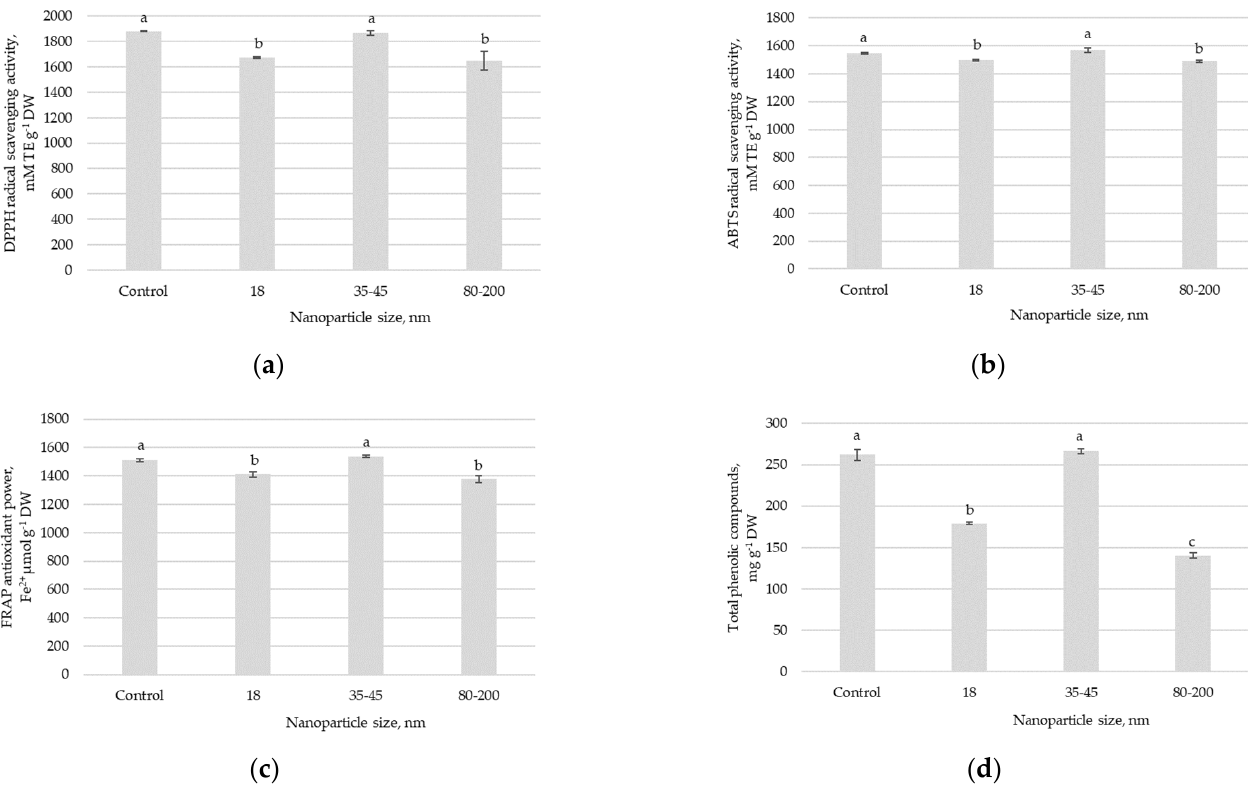
Figure 2. Particle size-dependent effects of ZnO nanoparticles on total phenolic content ( d ) and antioxidant properties DPPH ( a ), ABTS ( b ) and FRAP ( c ) of Swiss chard. Different letters represent significant differences. The data were processed using analysis of variance (ANOVA) and the Tukey (HSD) multiple range test at the confidence level p = 0.05.